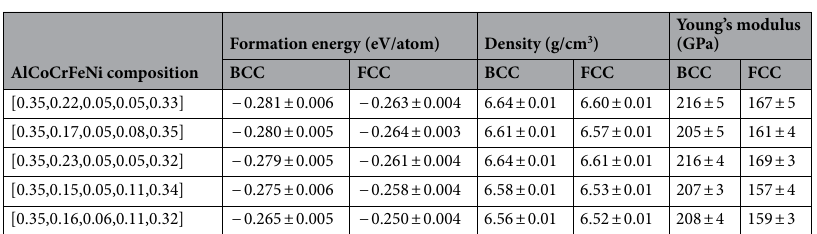
Formation energy (eV/atom) Density (g/cm 3 AlCoCrFeNi composition